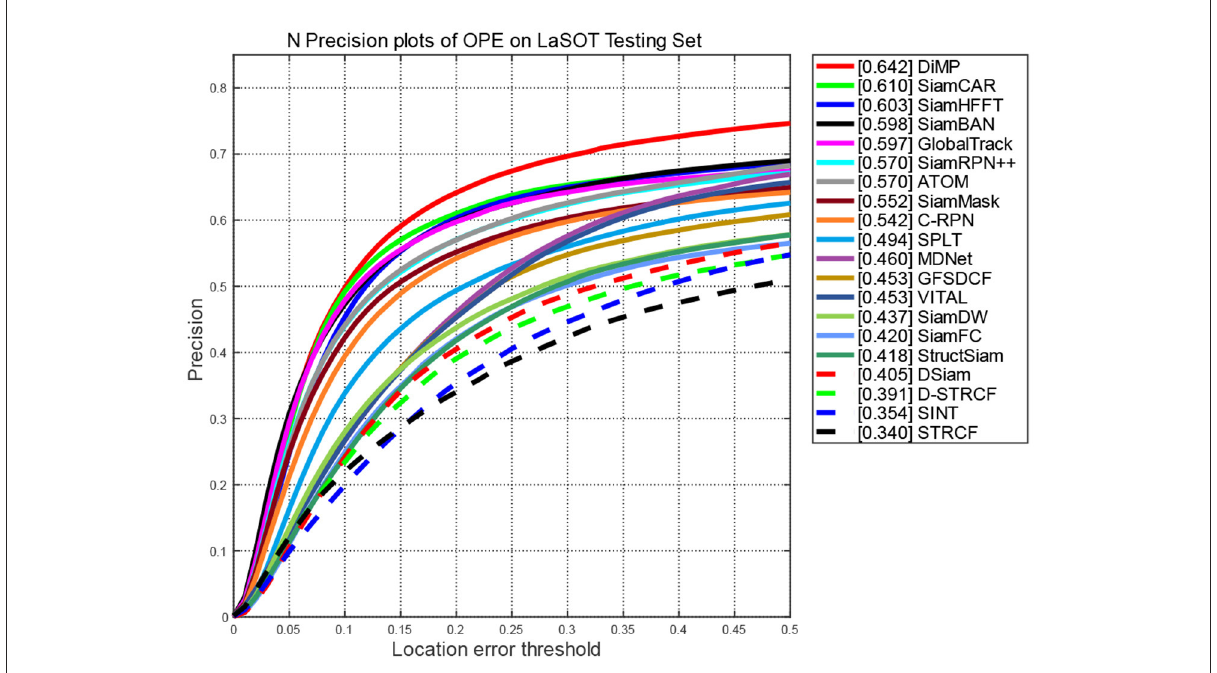
FIGURE4 Precision scores of compared trackers on LaSOT.